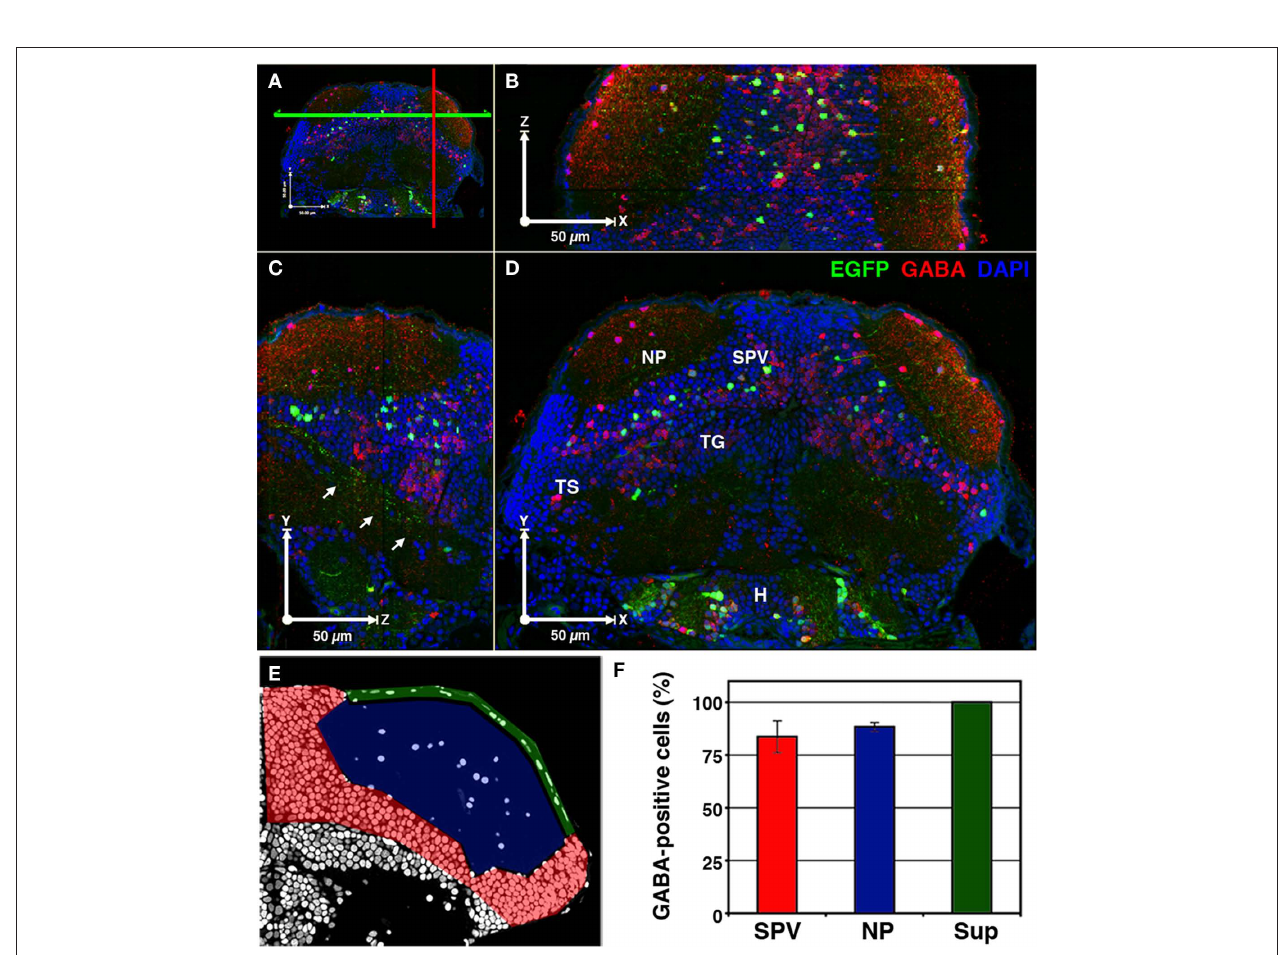
FiGure 1 | The dlx5/6:GFP transgene labels specific neuronal populations in the larval zebrafish brain. (A) A single confocal section acquired 40 μm below the dorsal surface of the brain. GFP transgene expression is observed in cells in the optic tectum (OT) and cerebellum (CB). (B) At a depth of 80 μm dense GFP labeling of cells is seen in the olfactory bulb of the telencephalon (T),